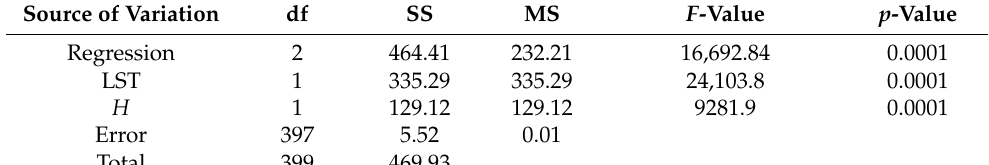
Table 3. Analysis of variance (ANOVA) and regression coefficients results for the suggested model. Source of Variation df SS MS F